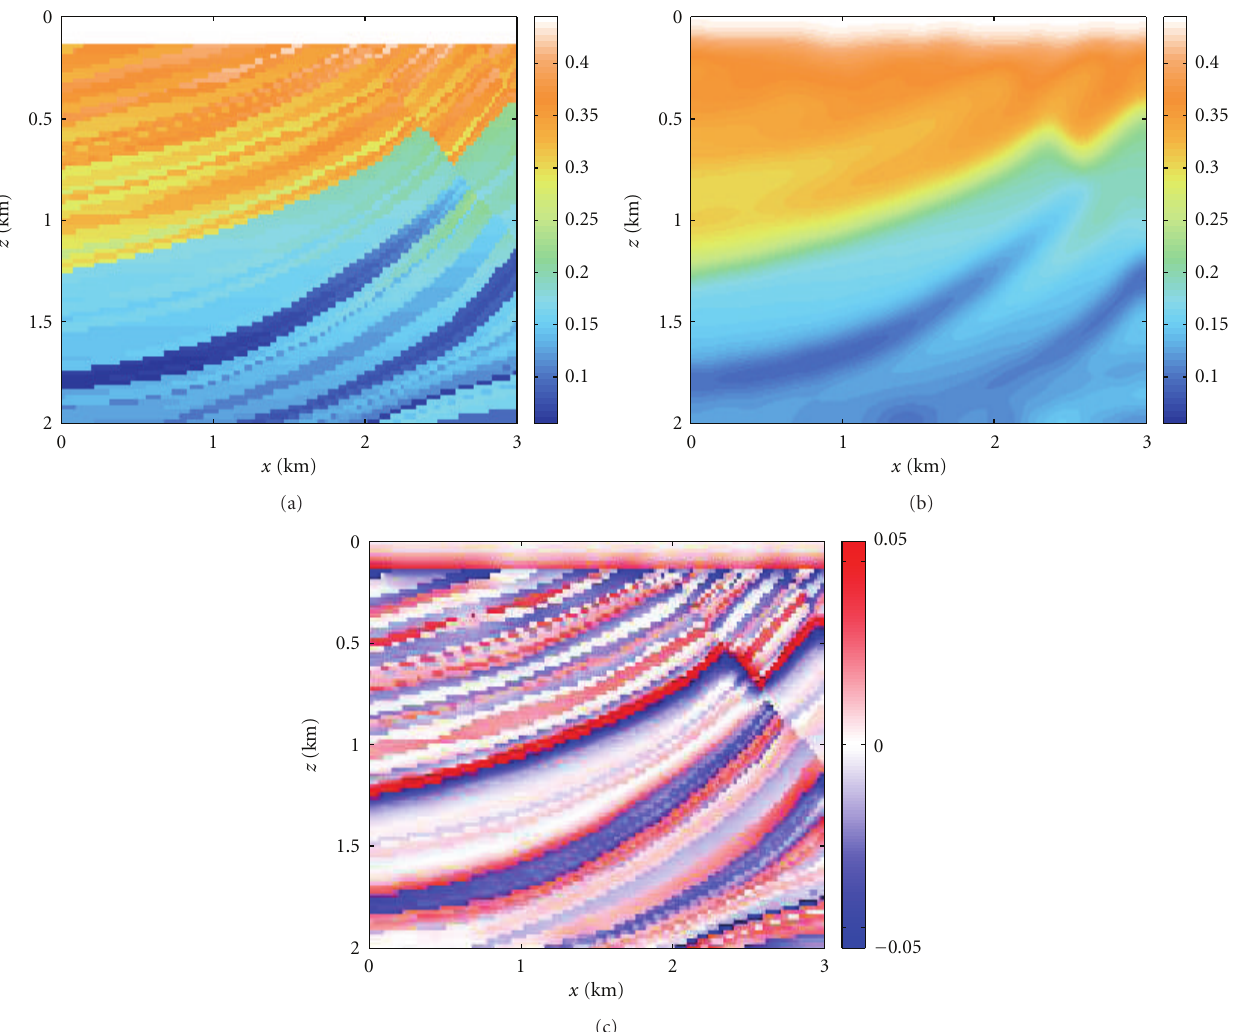
Figure 1: True (a) and initial (b) squared-slowness models (s 2 /km 2 ) and the true